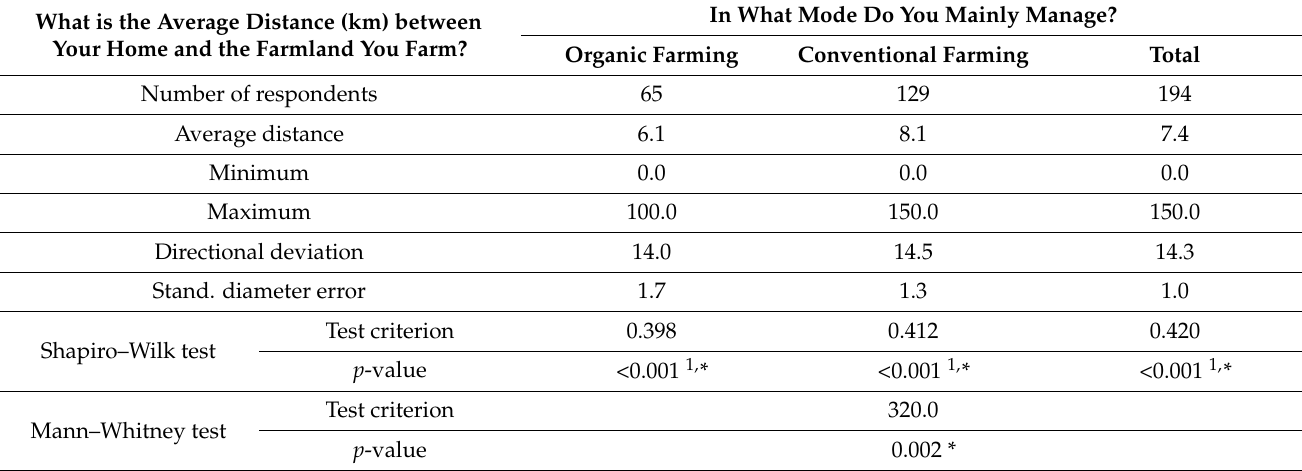
Table 3. Distance of the respondents’ residence from their cultivated